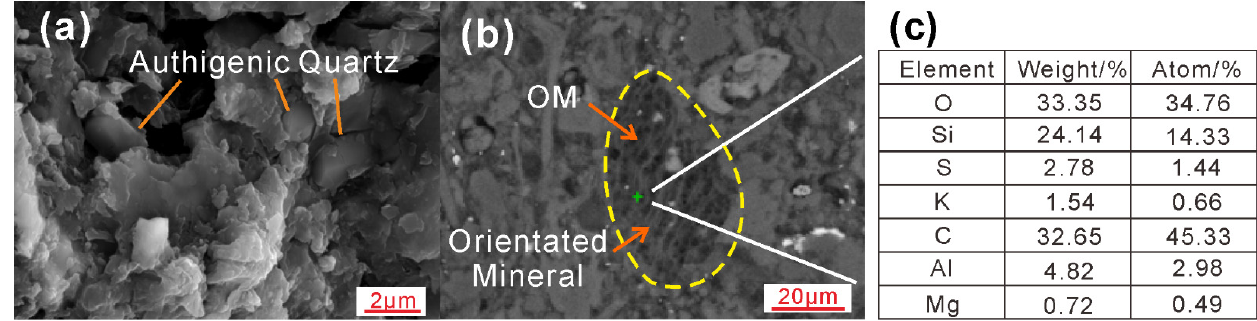
Figure 8. Quartz under SEM. ( a ) Authigenic quartz (N-2, secondary electron image, SE); ( b ) particle intergrowth of organic matter and orientated mineral (N-1, backscattered scanning electron microscope image, BSD).; ( c ) elemental composition of the green point in Figure 8b. EDX maps of the elements Si, Al, K, and Na were used to differentiate between quartz (Si-rich domains) and feldspar (Al-rich, or Na- and K-rich domains). Si enrich- ments occurring as “elongated” particles were counted separately (Figure 9). The Al scanning results of N-3 and N-5 were poor; therefore, K and Na were used as feldspar indicators particularly in these samples (Figure 9e,f).